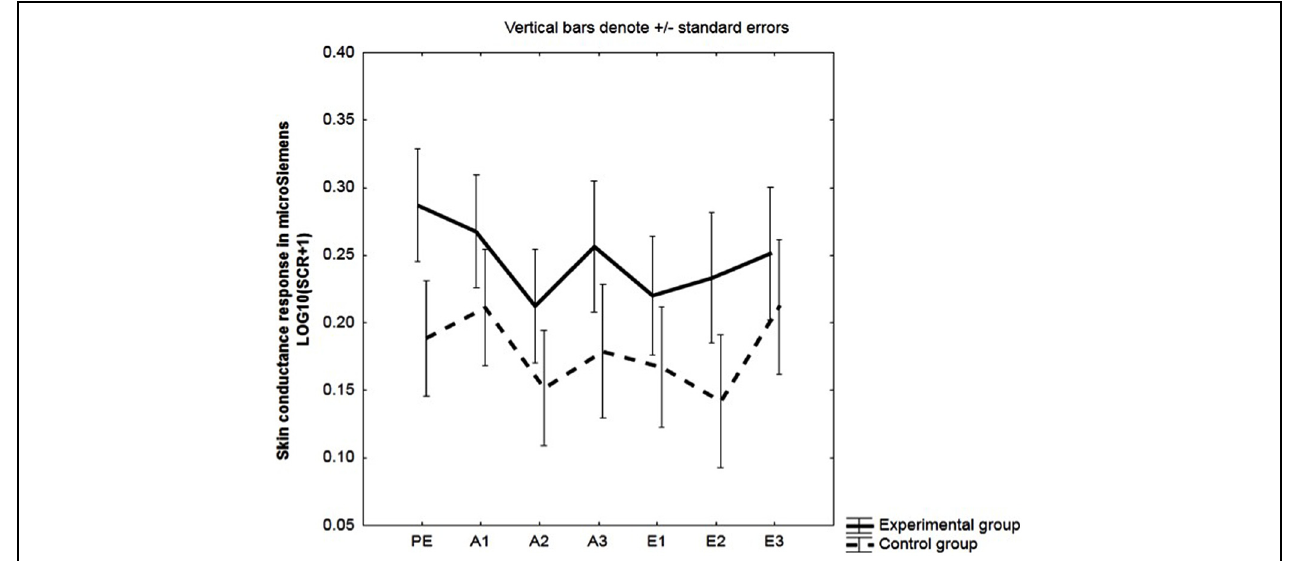
FIGURE 5 | Skin conductance responses (SCR) during the CS-period. Mean SCRs [LOG10 (1 + SCR)] in microSiemens during the CSs. SCRs were averaged across three pre-exposure trials (PE), two acquisition trials (A1, A2, A3), and two extinction trials (E1, E2, E3).